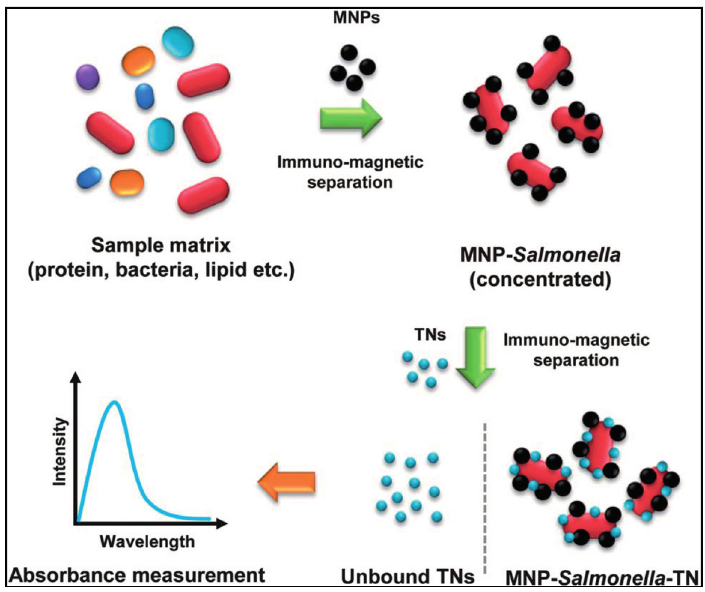
Figure 7. A schematic representation of the pathogenic bacteria detection method by using magnetic nanoparticles and optical nanoprobes (reproduced from [114] with permission of The Royal Society of